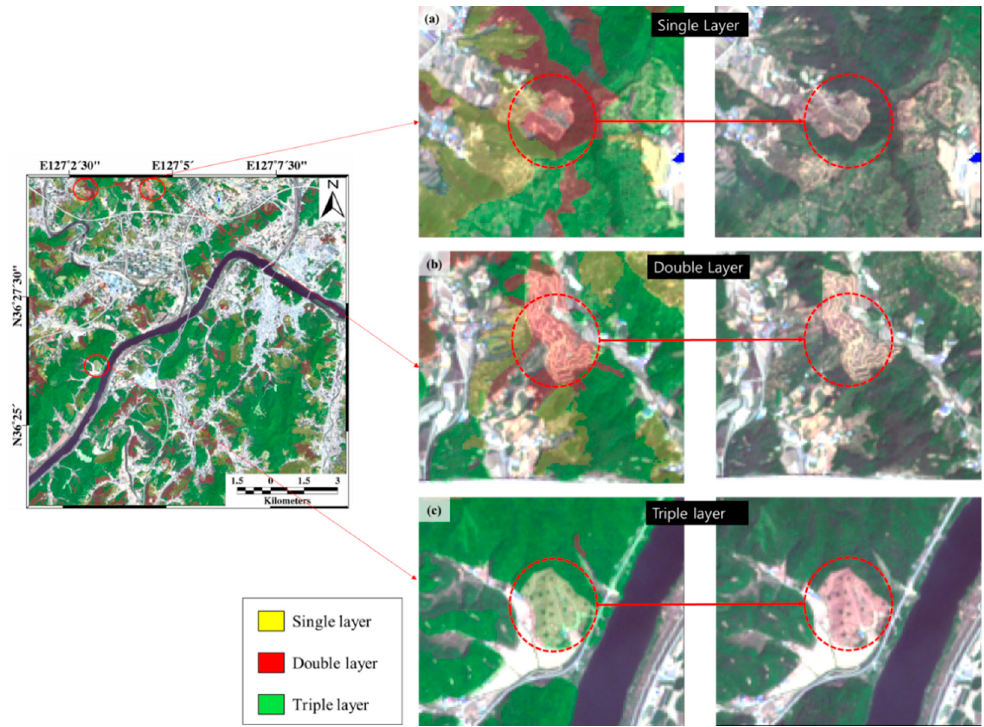
Figure 13. The forest vertical classification map with the original Sentinel-2 RGB image. ( a ) single-layer, ( b ) double-layer and ( c ) triple-layer structure